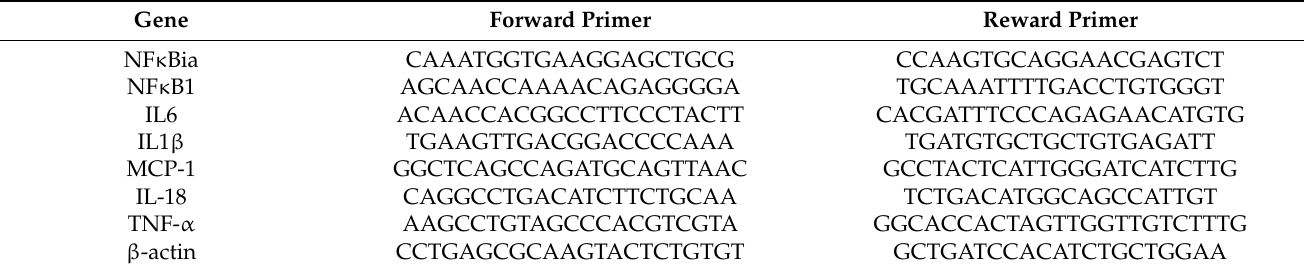
Table 3. Primers used in this